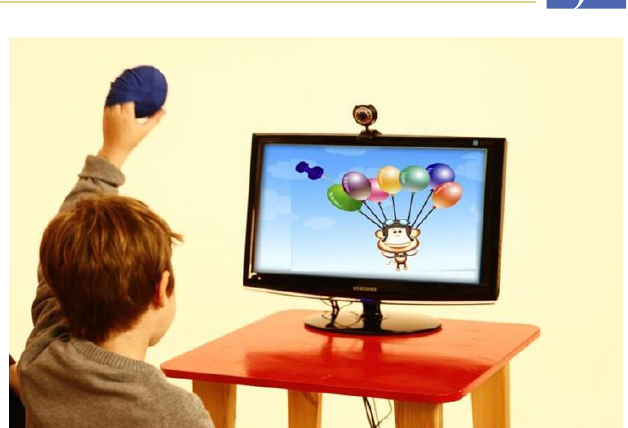
Figure 1. Timocco game set-up. The webcam is tracking the motions of the child by capturing the image of the gaming ball. In this image, the child’s goal is to virtually “pop” the balloons with the “push pin,” on the screen, which moves in real-time as the child moves his left upper